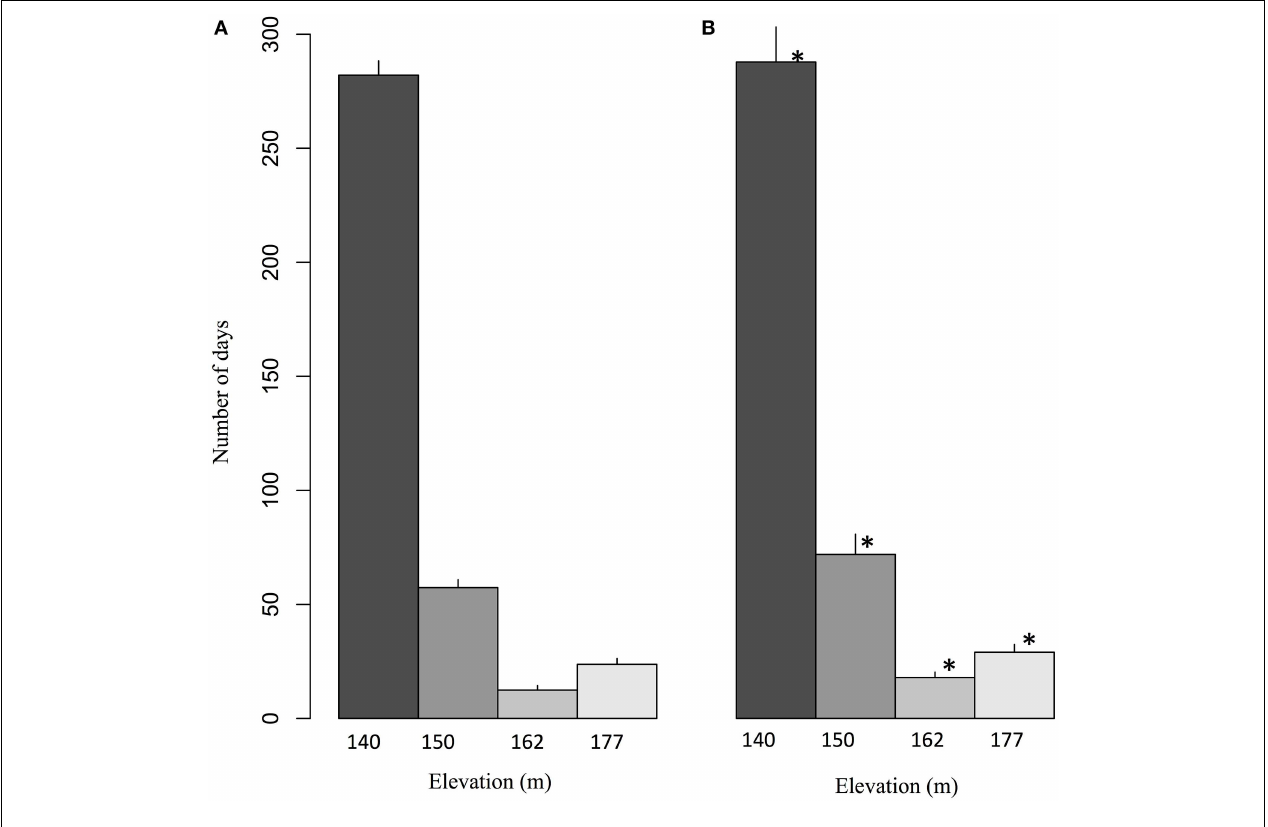
FIGURE 3 | Average number of days per year for which springs at different elevations are expected to flow during (A) the 1971–2000 reference period and (B) the 2041–2070 future period. The values correspond to ensemble averages and